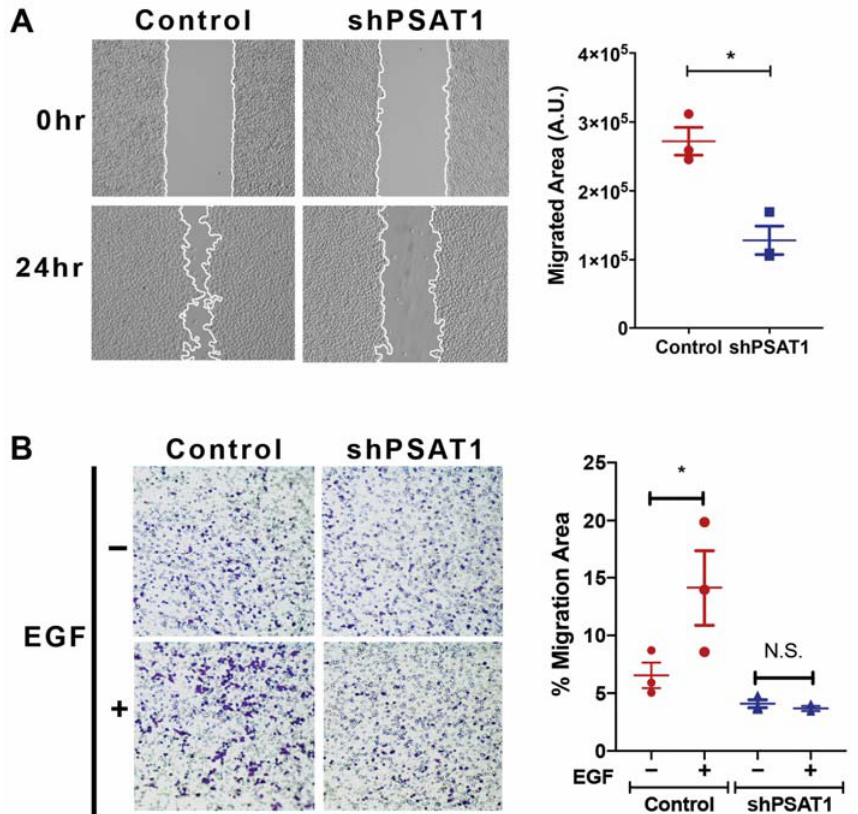
Figure 5. Loss of PSAT1 decreases cell migration in EGFR-mutant PC9 and EGF-stimulated A549 NSCLC cells. ( A ) Wound healing assay of PC9 cells expressing the control or PSAT1-specific shRNA. Shown are representative images taken at 0 h and 24 h. Migrating cells are demarcated by continuous white lines. Data are presented as a migrated area after 24 h and shown is the mean ± SE from three independent experiments. A statistical significance was determined by a paired t-test analysis. * is p < 0.005. ( B ) Boyden chamber migration assay on serum-starved A549 cells expressing the control or PSAT1 shRNA. A total of 100 ng/mL EGF serum-free media was used as a chemo-attractant and migrated cells were fixed and stained with crystal violet after 24 h. Shown are representative images of the migrated cells and quantification is demonstrated as the mean ± SE of the% migration area from three independent experiments. A statistical significance was determined by a two-way ANOVA with Tukey’s multiple comparison test. * p = 0.0001. N.S.: not significant; A.U.: arbitrary unit.